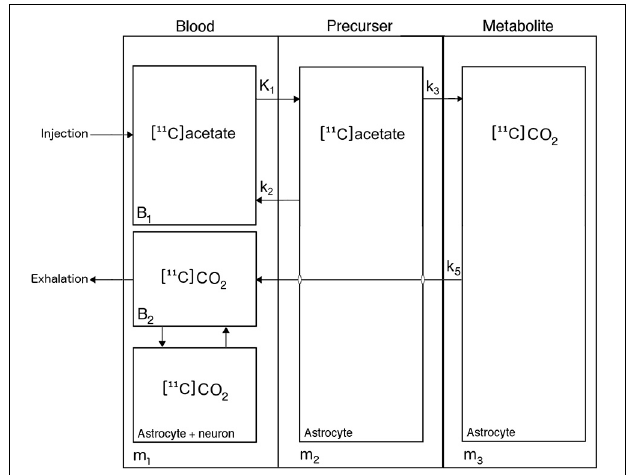
FIGURE 1 | Kinetic model of [ 11 C]acetate metabolism in human brain. [ 11 C]Acetate enters the astrocytes from blood through either carrier-mediated transport (MCT1) or passive diffusion, characterized by the unidirectional clearance K 1 , [ 11 C]Acetate in the astrocytes either return to blood, characterized by the rate constant k 2 , or is converted to [ 11 C]acetyl-CoA, thereby entering the tricarboxylic acid (TCA) cycle, where it is joined into amino acids produced from oxaloacetate and α -ketoglutarate, irreversible processes characterized by the rate constant k 3 , before it is converted to [ 11 C]CO 2 , which leaves the cell by passive diffusion into the blood, characterized by the rate constant k 5 .